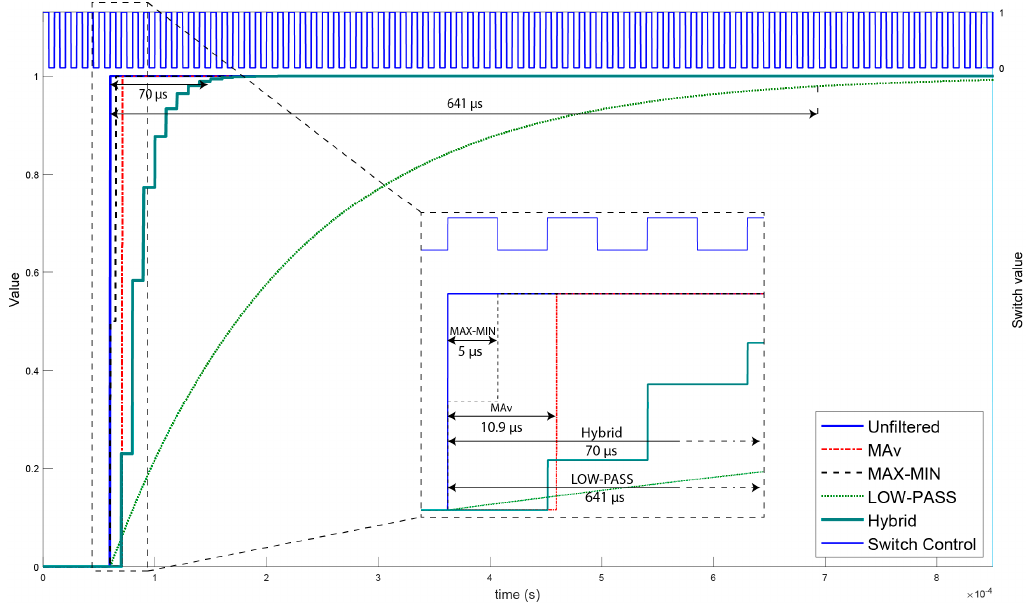
Figure 8. Comparison of the filters, applied to the step function signal.